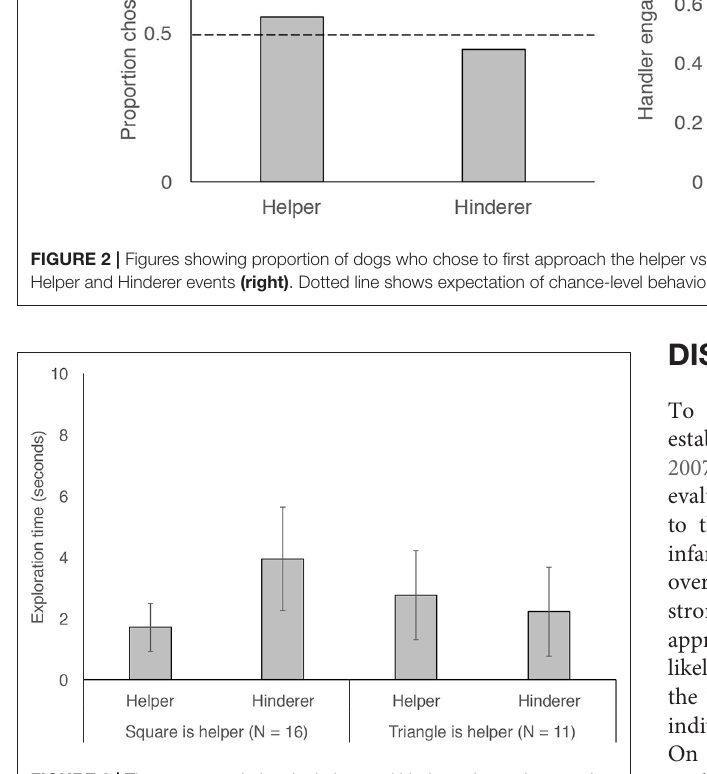
FIGURE 3 | Time spent exploring the helper and hinderer shapes in cases in which the helper was the blue square (left two bars) or the yellow triangle (right two bars). Error bars show 95% confidence